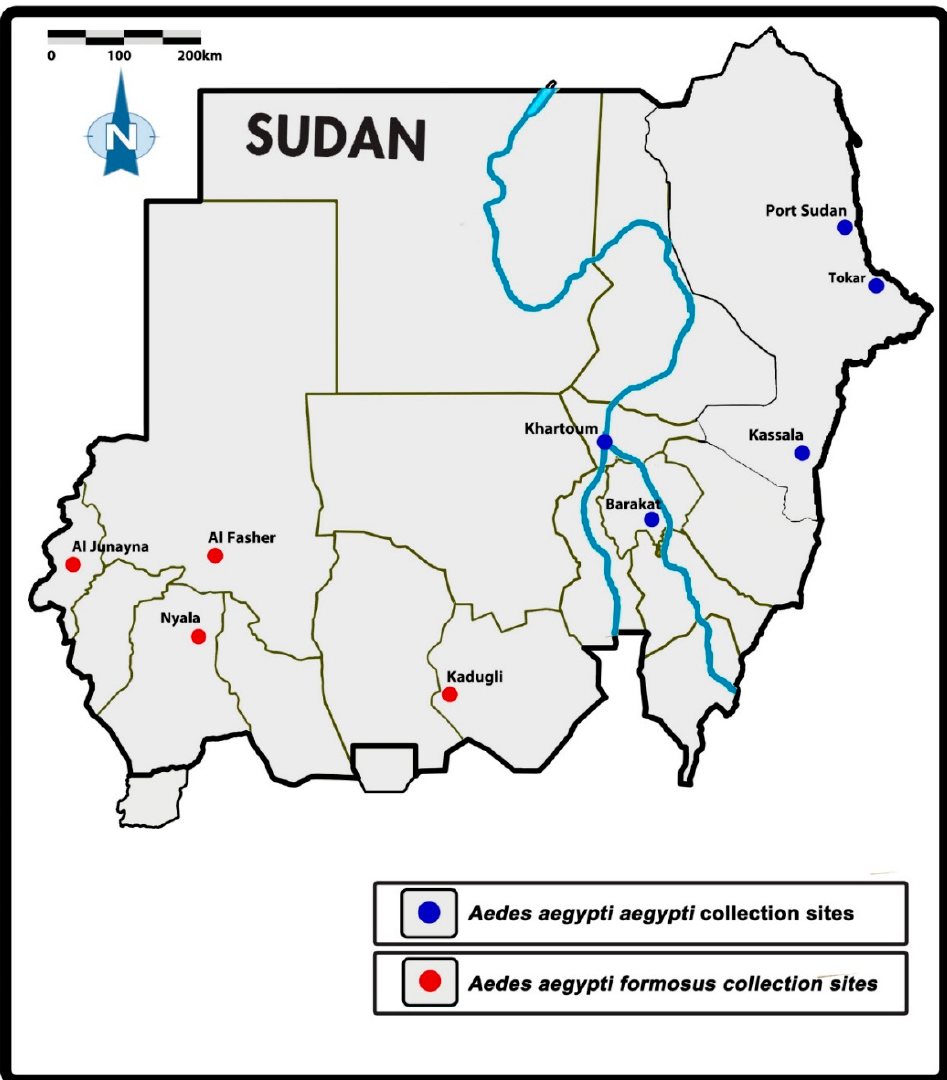
Figure 1. Map of the study locations in Sudan [8]. Aedes eggs, larvae and pupae were sampled from different breeding habitats (includ- ing clay pots, cement reservoirs, barrels, jerrycans, flowerpots, cement reservoirs, tires, and bathtubs) in the study area from 2014 to 2017. At each site, there were five sampling points (inter-point distance of at least 1 km) to avoid sibling bias in the sample collection. The samples were transferred to the insectarium for sorting and morphological identifi- cation [22] (Table 1). The samples were maintained at a temperature of 25 ◦ C, relative humidity of 80–90% and a 12 h Light:12 h Dark photoperiod and fed with larval food until adult emergence. Identification of adults into subspecies was performed using the key of Huang [23] based on the presence or absence of a batch of median white scales on the first abdominal tergite. Each sample was preserved in a labeled microfuge tube (Thermo Fisher Scientific, MA, USA) containing 70% isopropanol and stored at − 20 ◦